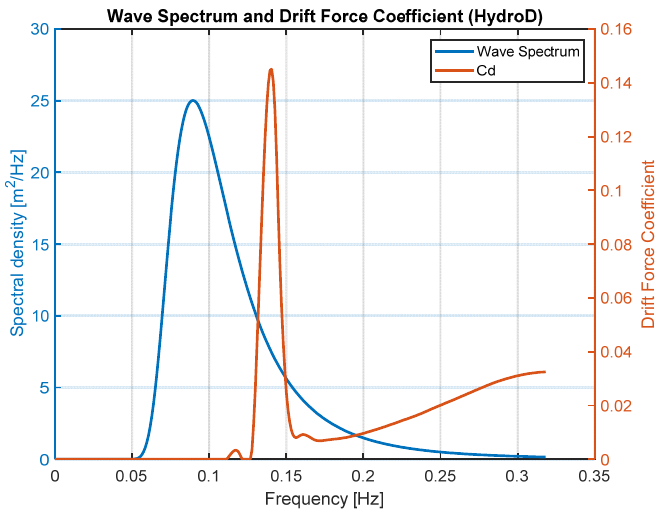
Figure 2. Wave spectrum and drift force coefficient as a function of frequency.